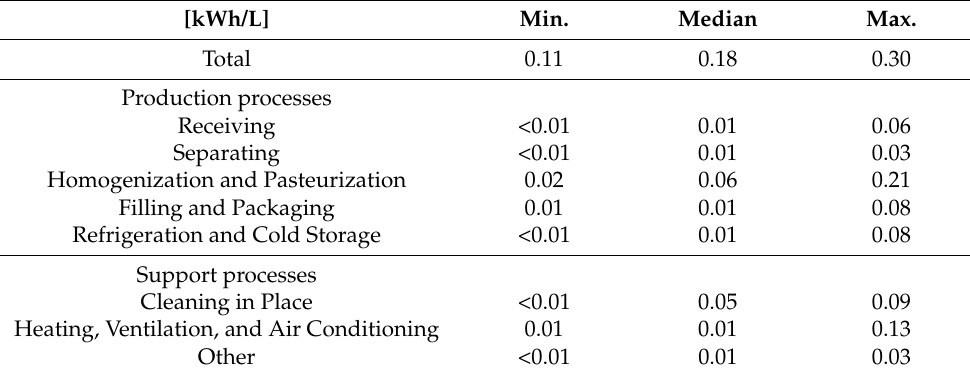
Table 2. Process-level benchmarking in fluid milk plants. Based on data from